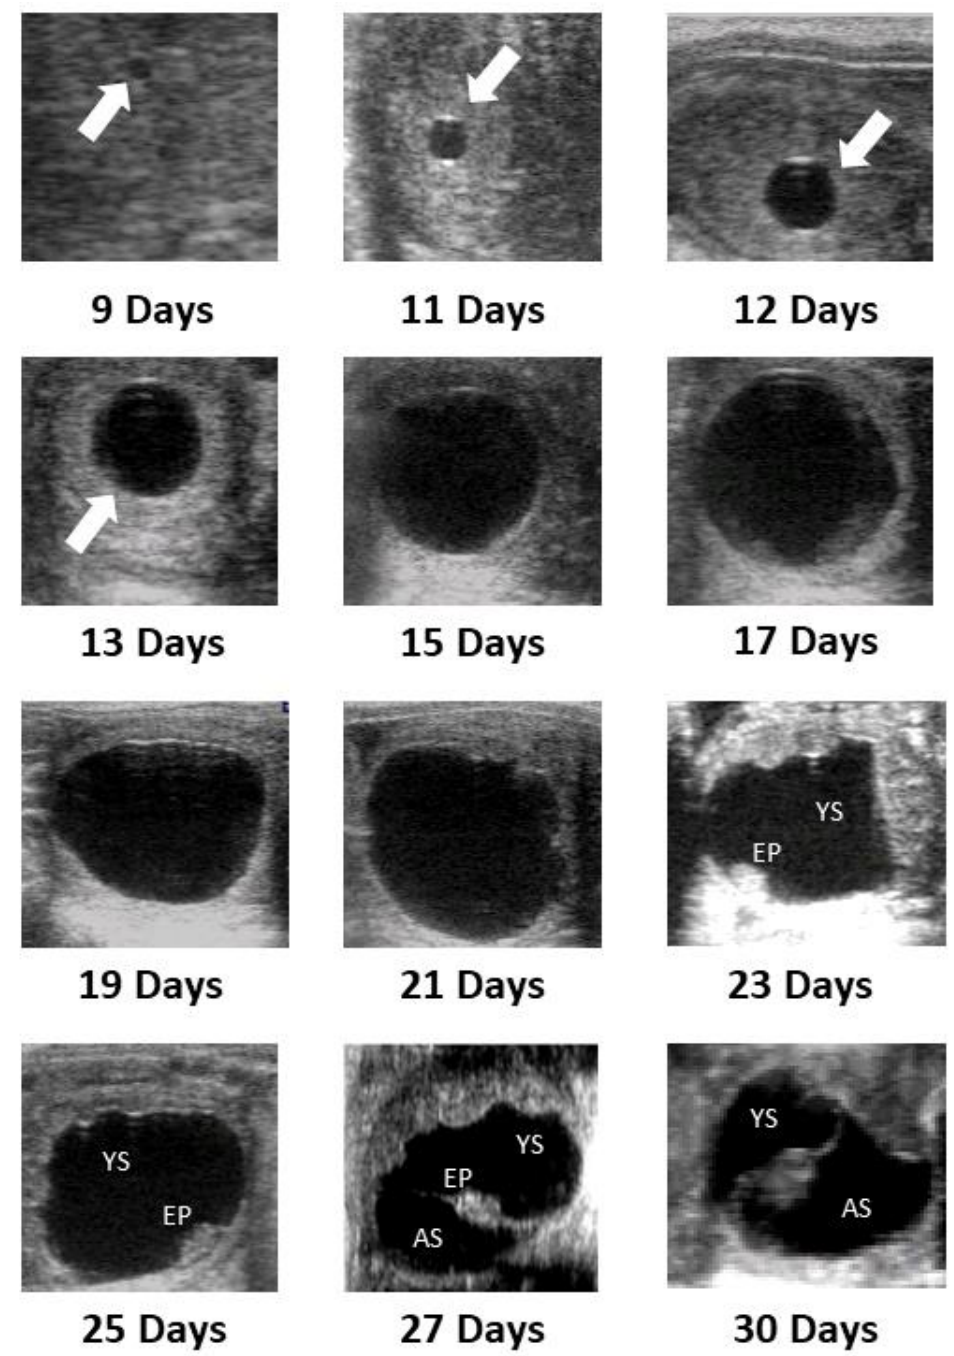
Figure 5. Ultrasound images of the major developmental milestones of the conceptus from Day 9 (day of first detection) to Day 30 of pregnancy in jennies. EV, embryonic vesicle; YS, yolk sac; EP, embryo proper; AS, allantoic sac.